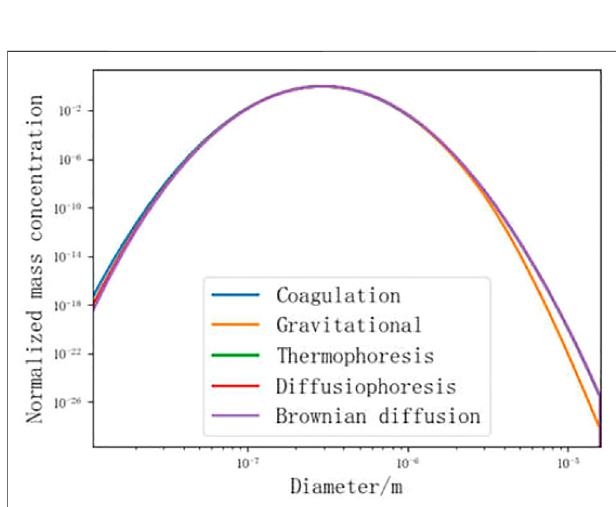
FIGURE 11 | Effect of the deposition mechanism on the distribution of aerosol diameter